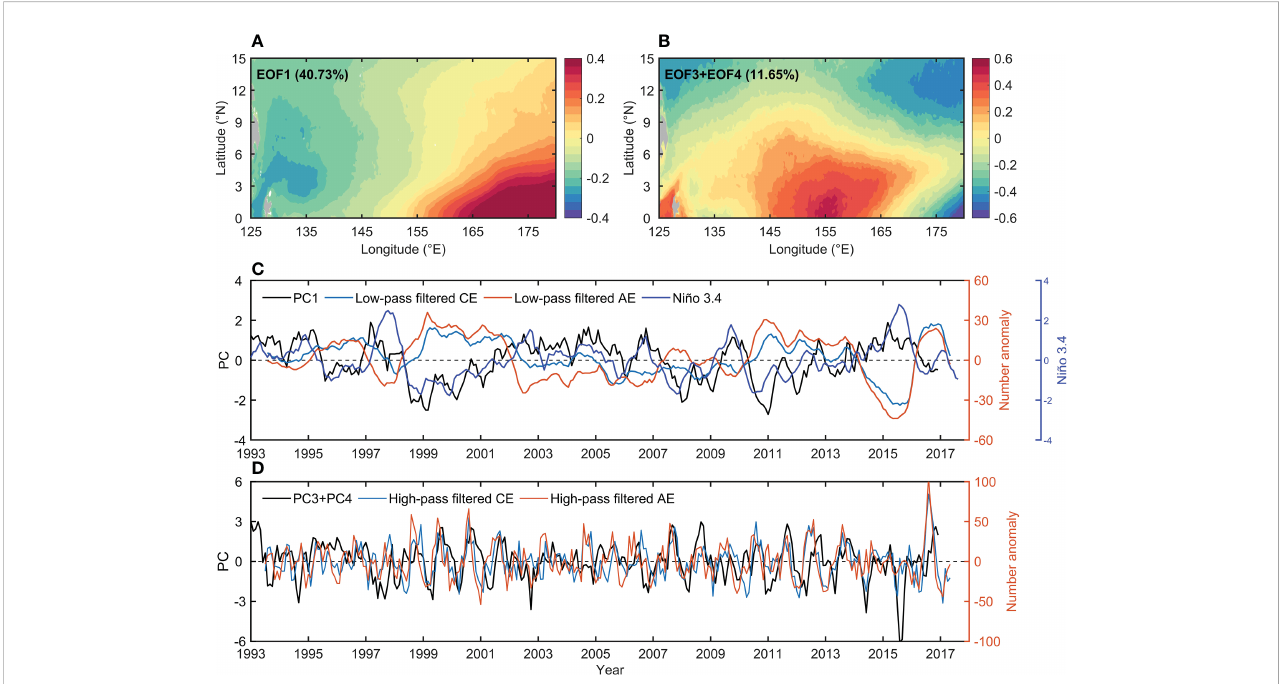
FIGURE 8 Empirical orthogonal function (EOF) for SST (1993 – 2016) in western Paci fi c warm pool region and comparison of different modes with MEs. (A, B) The EOF mode 1, the sum of modes 3 and 4 for SST, and (C, D) their corresponding PC time series. The percentage of variance explained by each mode is displayed in the upper-left corner of each EOF panel. The PC time series from top to bottom are superimposed on the low-pass fi ltered eddy numbers, Niño 3.4 index (C) , and high-pass fi ltered eddy numbers (D) . See Figure S6 for original EOF